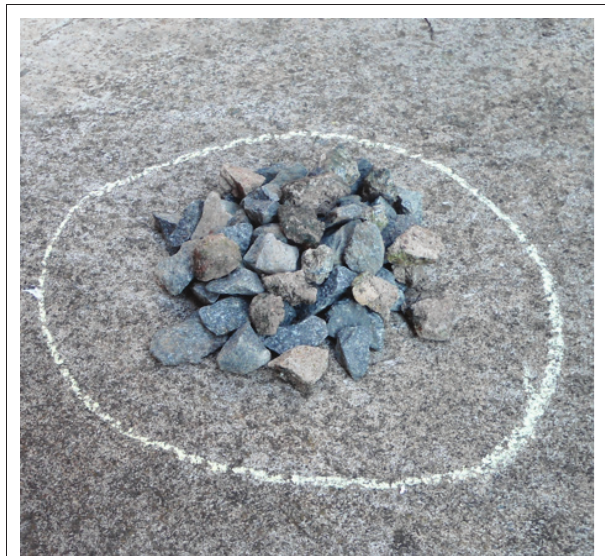
FIGURE 2: Heaped stones in a circle.